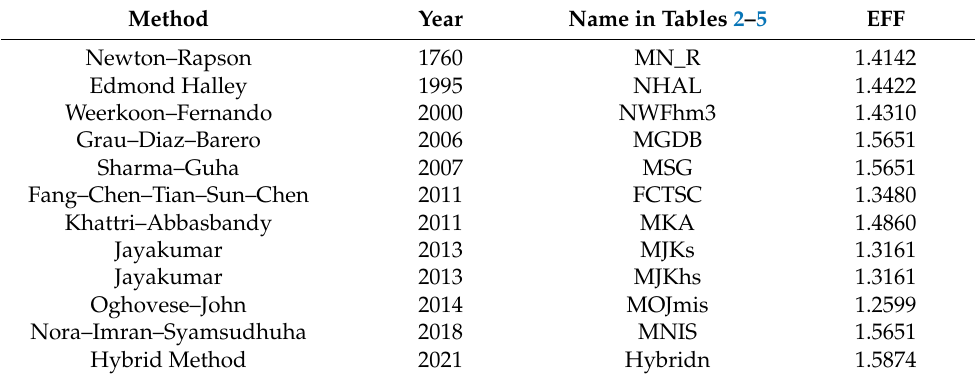
Table 1. Methods used in Tables 2–5 with Efficiency Index